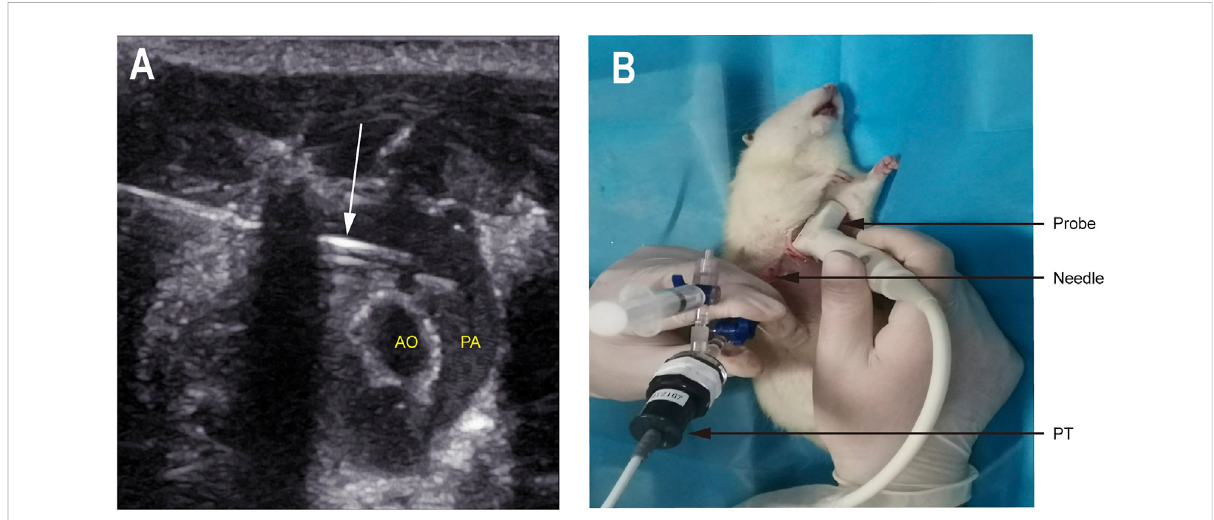
FIGURE 3 Echocardiography guided transthoracic puncture measurement of pulmonary artery pressure. (A) The puncture needle tip (white arrow) was located in the PA. (B) The actual operation of PA puncture by echocardiography was guided. Abbreviations: PA, pulmonary artery; AO, aorta; PT, pressure